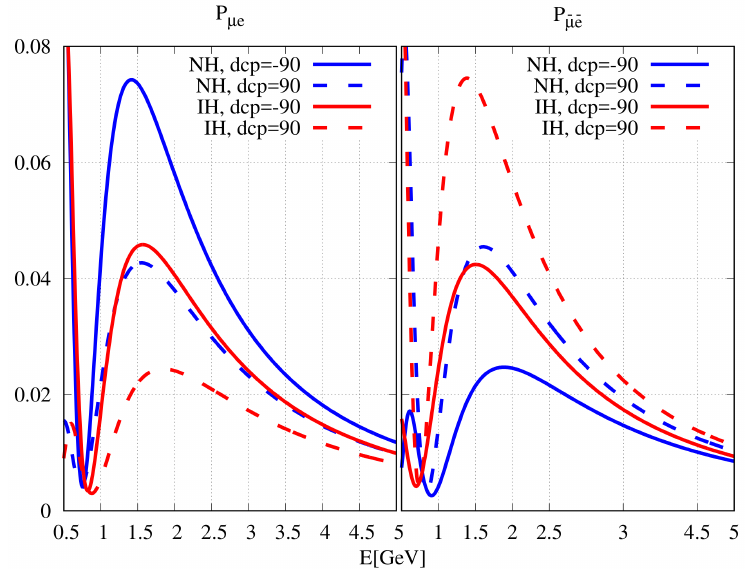
Figure 1. P µ e ( left panel ) and P ¯ µ ¯ e ( right panel ) vs. neutrino energy for the NO ν A baseline. Variation of δ CP leads to the blue (red) bands for NH (IH). The plots are drawn for maximal θ 23 and other neutrino parameters given in the main